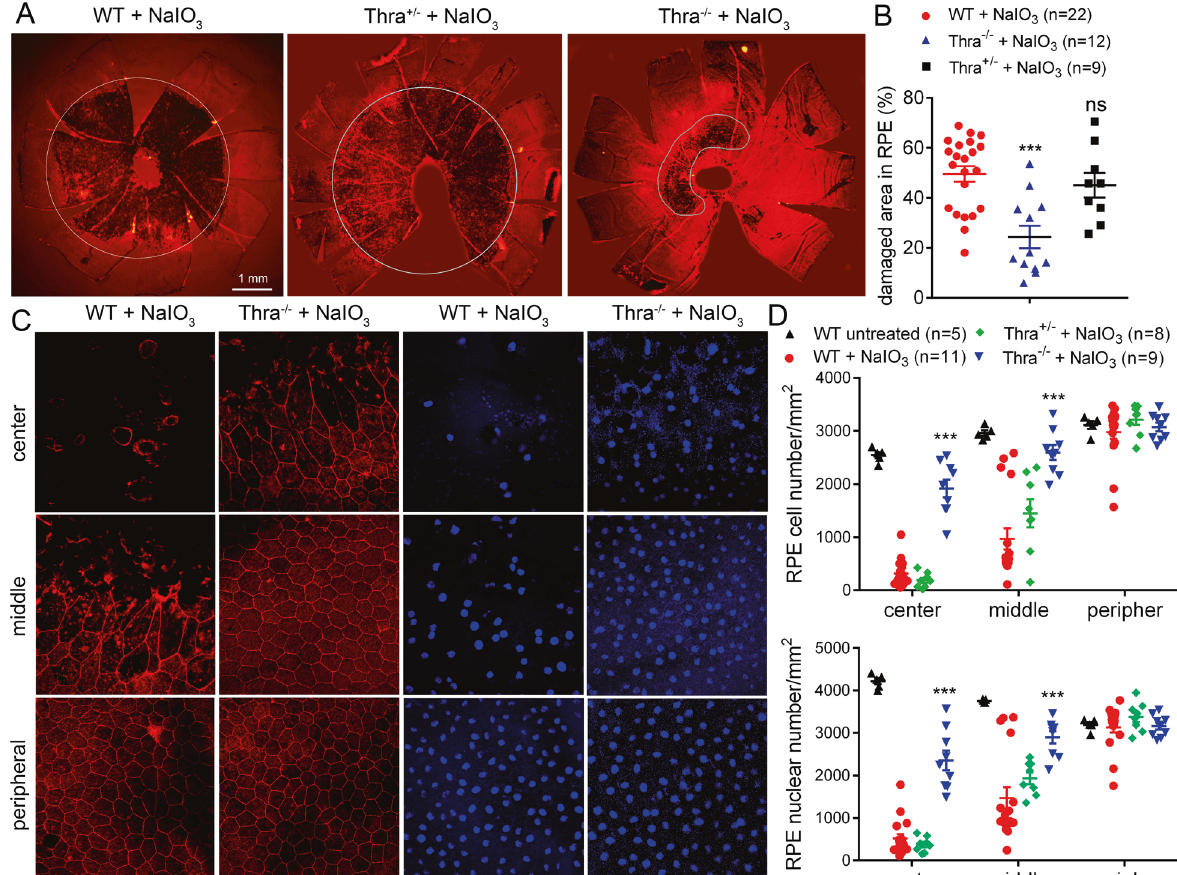
Fig. 1 Deletion of Thr α 1 protected RPE from cell damage/loss induced by NaIO 3 . RPE morphology and cell loss were evaluated by phalloidin staining for F-actin and DAPI staining for nucleus on RPE whole mounts prepared from Thr α 1 − / − , Thra1 + / − , and wild-type mice at 3 days post NaIO 3 injection. A , B Shown are representative low-magni fi cation images of phalloidin staining of the damaged area in the RPE ( A ) and corresponding quantitative analysis of the damaged area ( B ). C , D Shown are representative high-magni fi cation images of phalloidin staining and DAPI labeling taken at different regions of the RPE ( C ) and corresponding quantitative analysis of RPE cell numbers and RPE nuclear numbers ( D ). Data are represented as means ± SEM for 5 – 22 mice per group (** p < 0.01, *** p < 0.001, compared with wild-type mice treated with NaIO 3